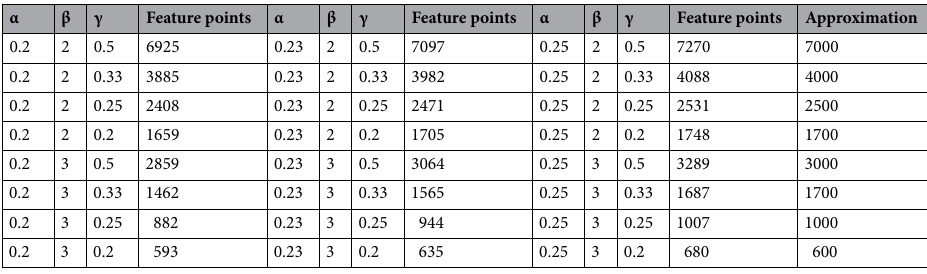
Table 3. The number of feature points with different parameters α, β, γ.